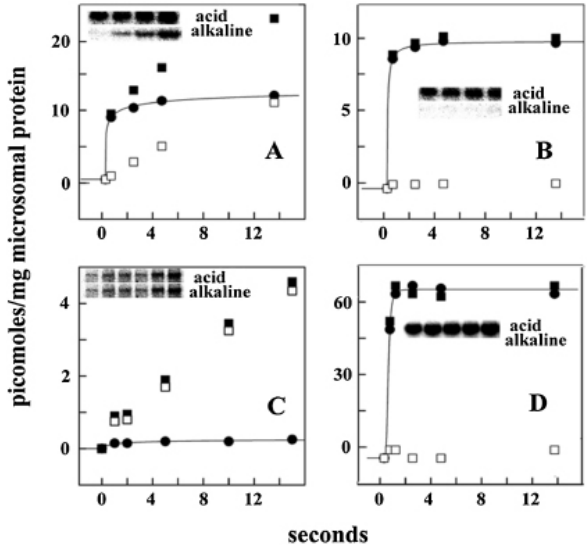
Figure 8. Phosphorylation of WT ATP7B (A, B), ATP7B D1027N mutant (C), and WT SERCA (D), in the absence (A, C and B) and in the presence of Proteinase K inhibitor. Microsomes obtained from COS-1 cells sustaining expression of the various ATPases were incubated with 50 microM (gamma - 32 P)ATP in a reaction mixture sustaining enzyme activiy at 30 o C, in the absence (A, C and D) or in the presence (B) of PKD inhibitor. Electrophoresis was then performed at acid pH to measure total phosphoproteins (black squares), or alkali pH to eliminate alkali labile phosphoenzyme and assess alkali resistant serine phosphorylation (empty squares). The difference (given in solid black circles) corresponds to the phosphorylated aspartate enzyme intermediate.